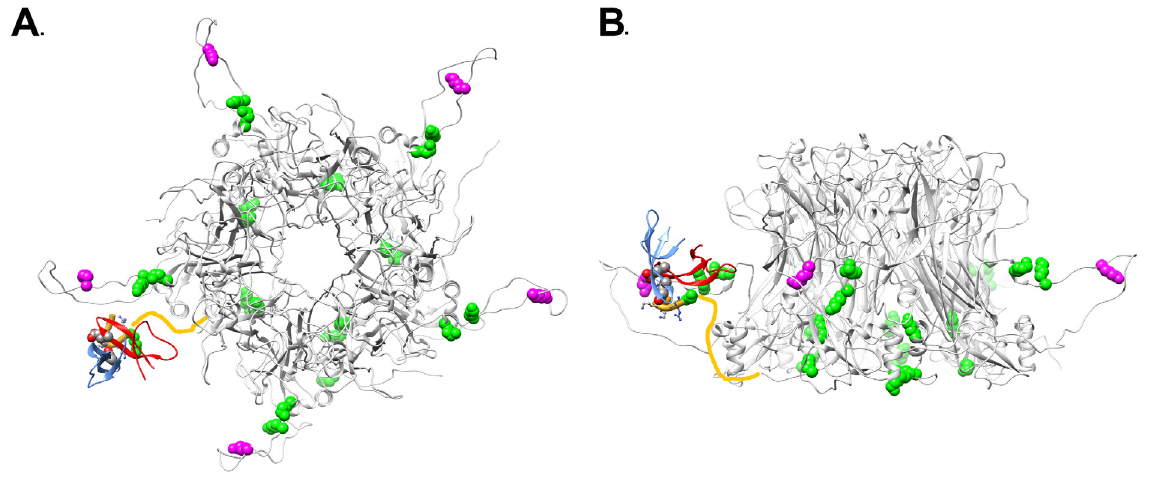
Figure 7. Overview of L1 lysine residues affected by HD5 with modeled position of HD5 dimer and L1 C-terminal tail. (A) Top view of an L1 pentamer (PDB: 5KEP, Chains B-F) with the lysine acetylation sites affected by the presence of HD5 in space-filling representation. The most affected lysine (K430) is in magenta and the other affected lysines (K437, K442, K467, K475, K484, K499) are in green. Some of the affected lysines are in the portion of the L1 C-terminal tail depicted as a yellow line (K484, K486). The MD-derived model of the HD5 dimer and the last 6 residues of the L1 C-terminal tail (aa 499-505) are in the same orientation with respect to the HPV capsid as in Figure 6. (B) Side view of panel